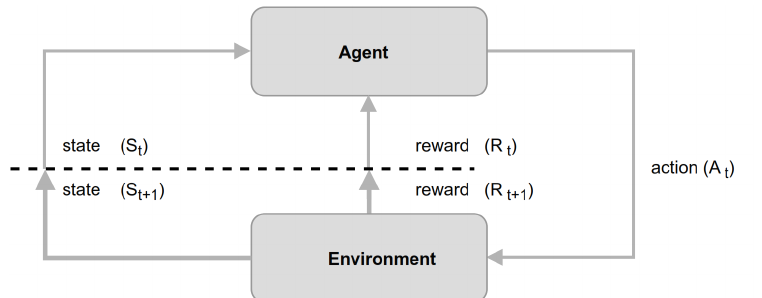
Figure 3. RL scheme. The agent takes an action ( A t ) from a set of tasks within an environment and this, in turn, changes from one state of the environment to